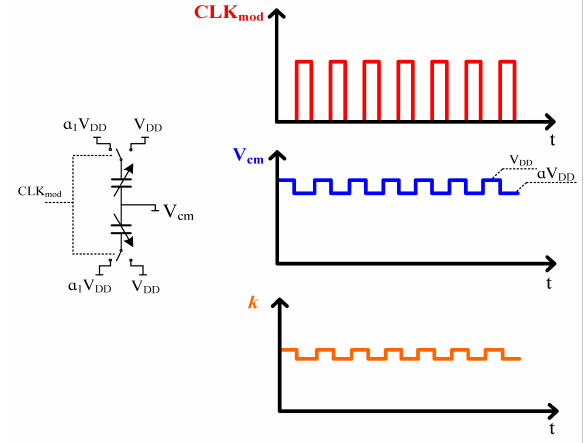
Figure 6. Spring k modulation